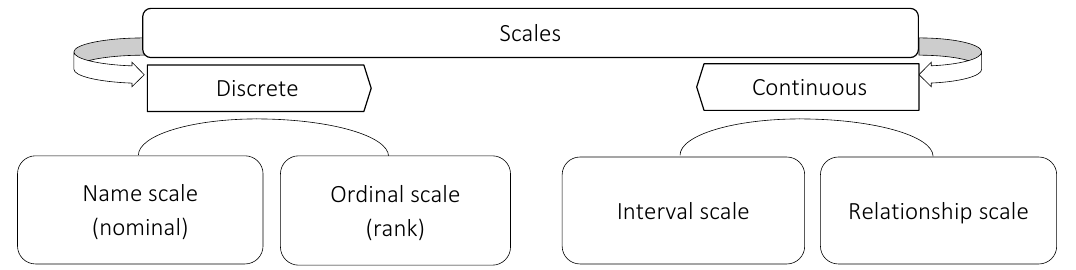
Figure 4. Scale types for qualitative measurement of results